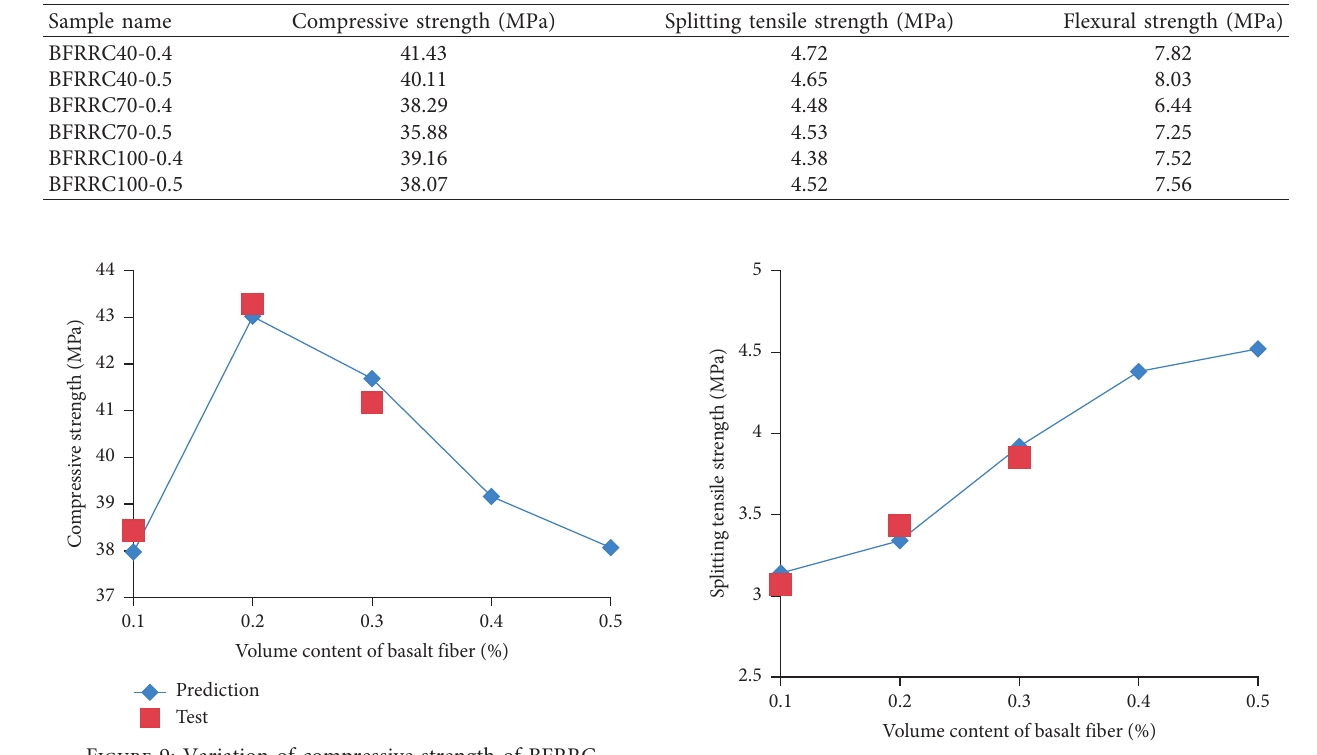
Table 6: Strength prediction results of BFRRC.